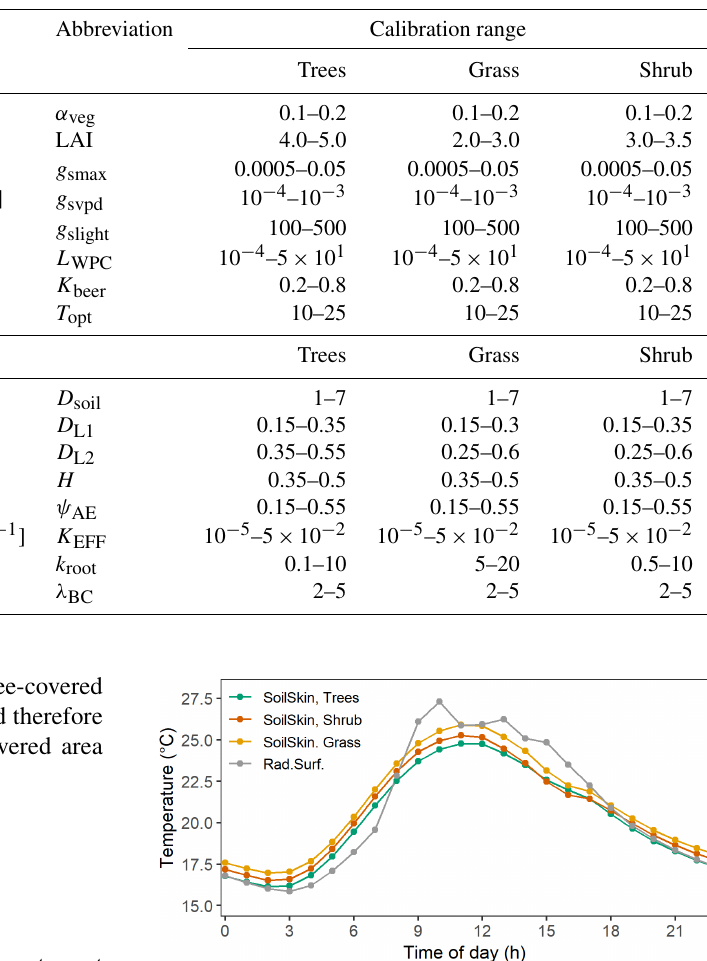
trees and shrub, however, did pick up the two events (Fig.